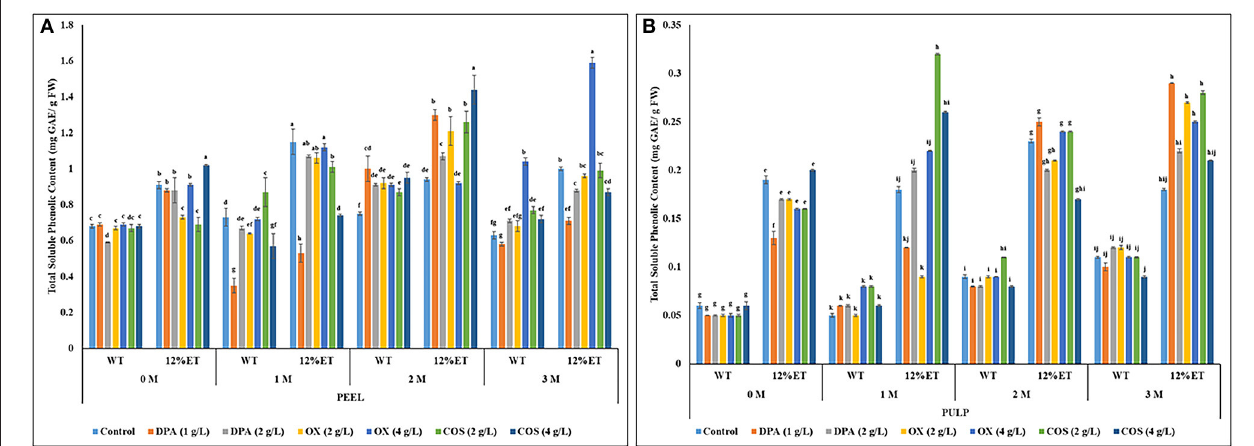
FIGURE 2 | Total soluble phenolic content (mg Gallic Acid Equivalent/ g Fresh Weight) of aqueous (WT) and ethanol (12%ET) extracts of Cortland apple peel (A) and pulp (B) with elicitor treatments during 3 months of storage. Error bars represent standard errors (S.E.). Different lowercase letters indicate statistically significant ( p ≤ 0.05) differences in total soluble phenolic content between sample (peel vs. pulp) × extraction solvent × post-harvest elicitor treatment interactions separately for each storage time